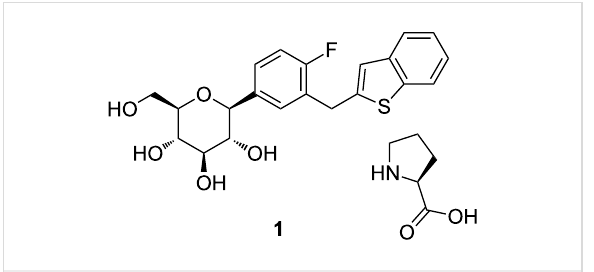
Figure 1: Structure of ipragliflozin L-proline.